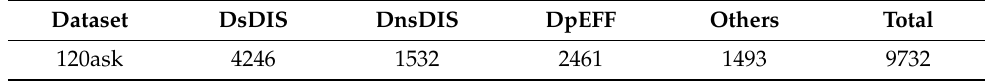
Table 1. Annotation relationship statistics in corpus.